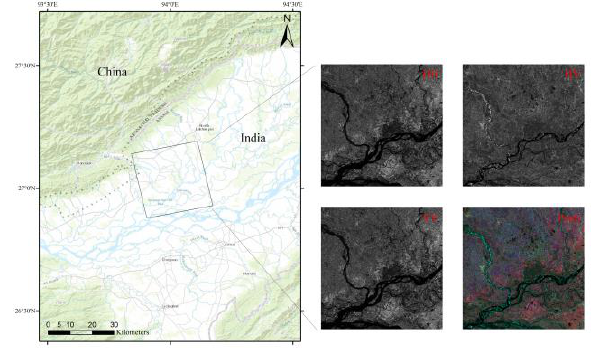
Figure 1. Overview map of study area (left) and HH, HV, VV and Pauli colour composite images from ALOS-2